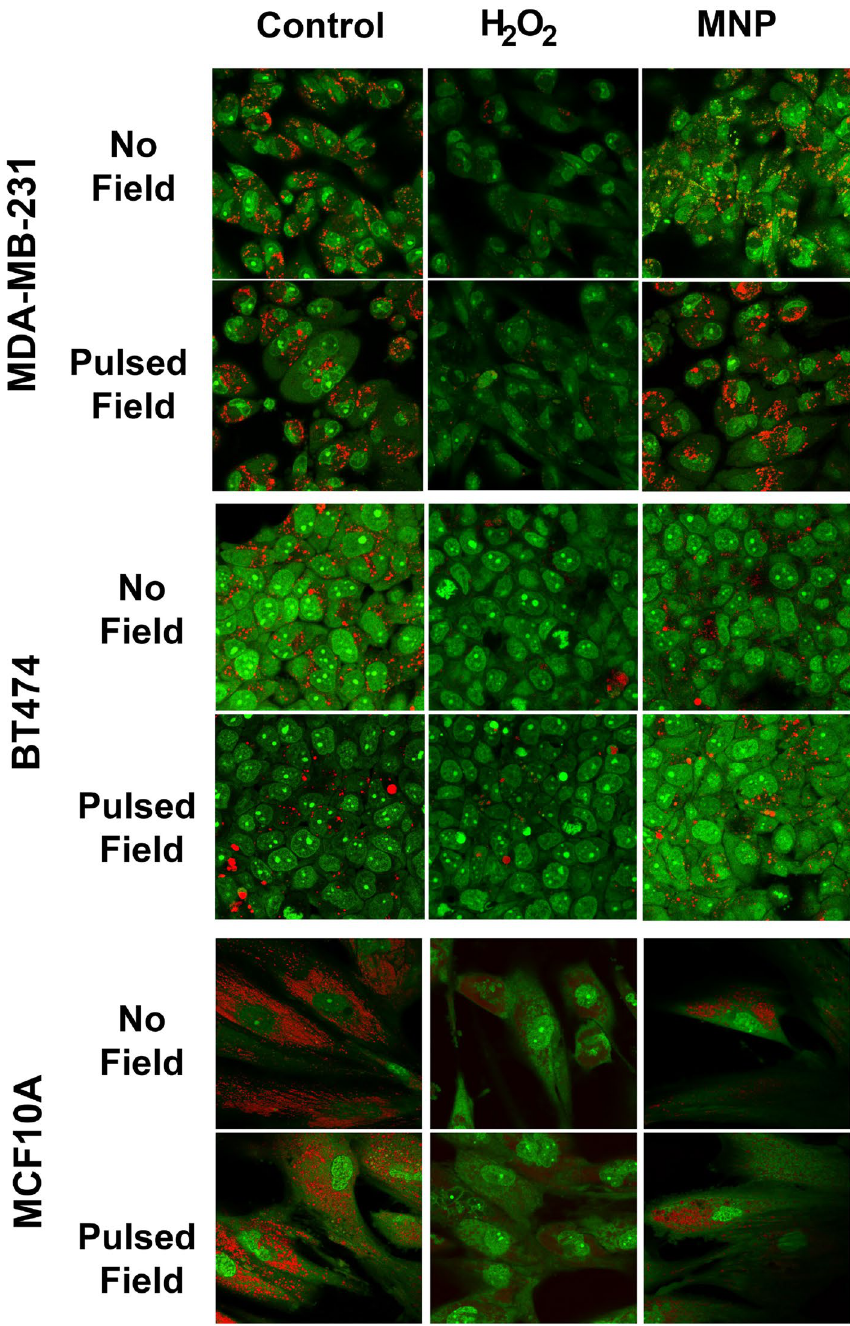
Figure 4. LMP detection using acridine orange in SMNP-treated MDA-MB-231, BT474 and MCF10A cells before and after pulsed field exposure. Cells were incubated with PAA-P85-SMNP for 24 h at 37 °C, washed and exposed to the 50 Hz pulsed AC magnetic field. (50 kA/m). After three hours, cells were incubated with 10 μg/ mL acridine orange for 15 min. Positive control cells were treated with 150 μM hydrogen peroxide for three hours. The cells exposed to hydrogen peroxide exhibit loss of punctate red fluorescence while negative controls and cells treated with SMNPs do